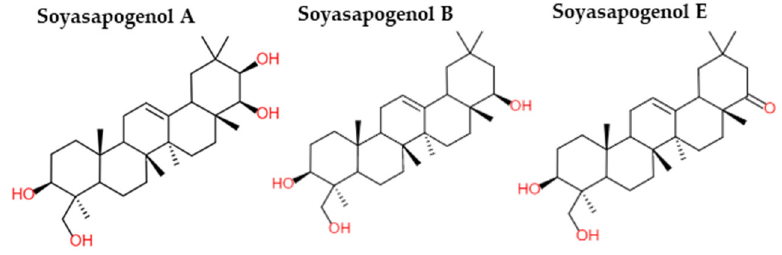
Figure 2. Chemical structures of soyasapogenol A, B and E (adapted from